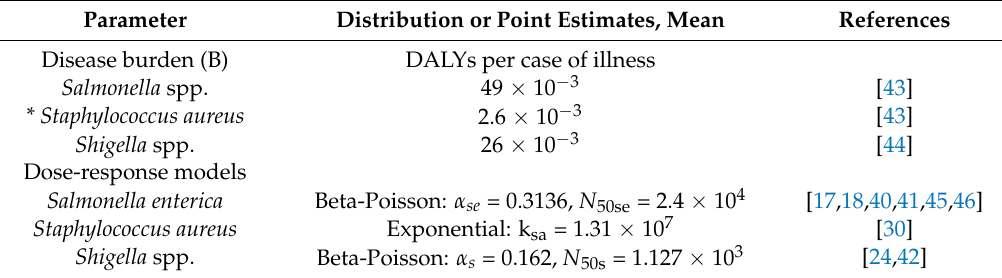
Table 3. Dose-response parameters for all bacteria under